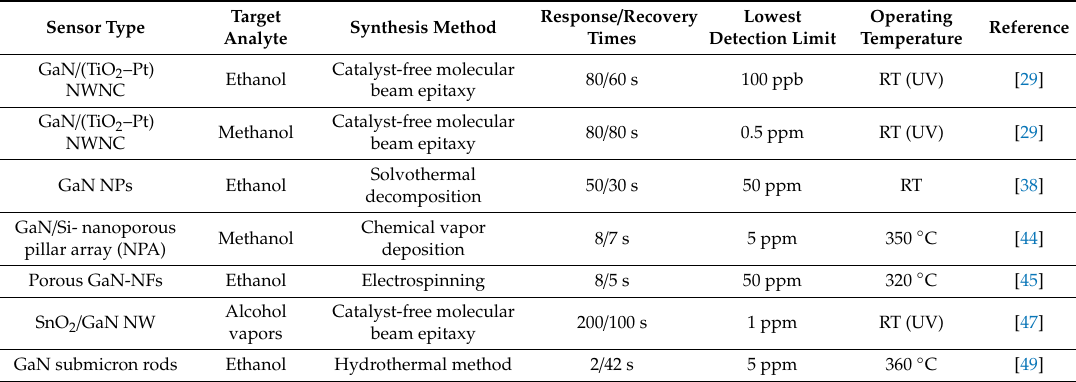
Table 2. Synthesis and sensing properties of GaN nanostructures-based alcohol